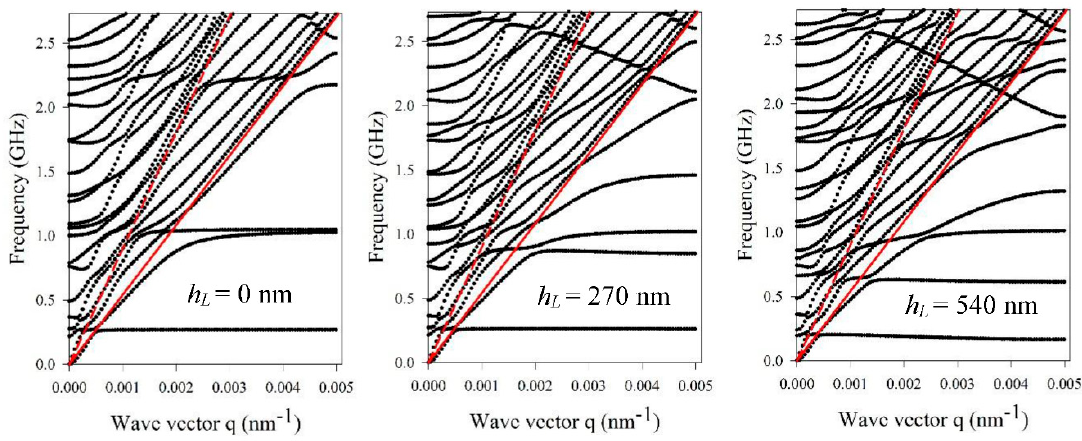
Figure 9. Dispersion curves calculated in the direction perpendicular to the nanoridges for different heights of the liquid (Cargille) infiltrating the grooves of height h = 540 nm.